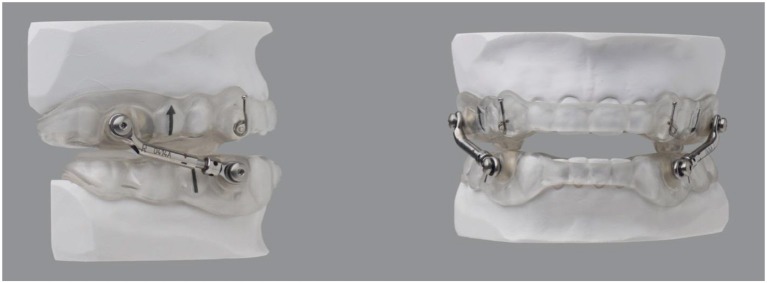
Herbst-style MAD used for all patients.